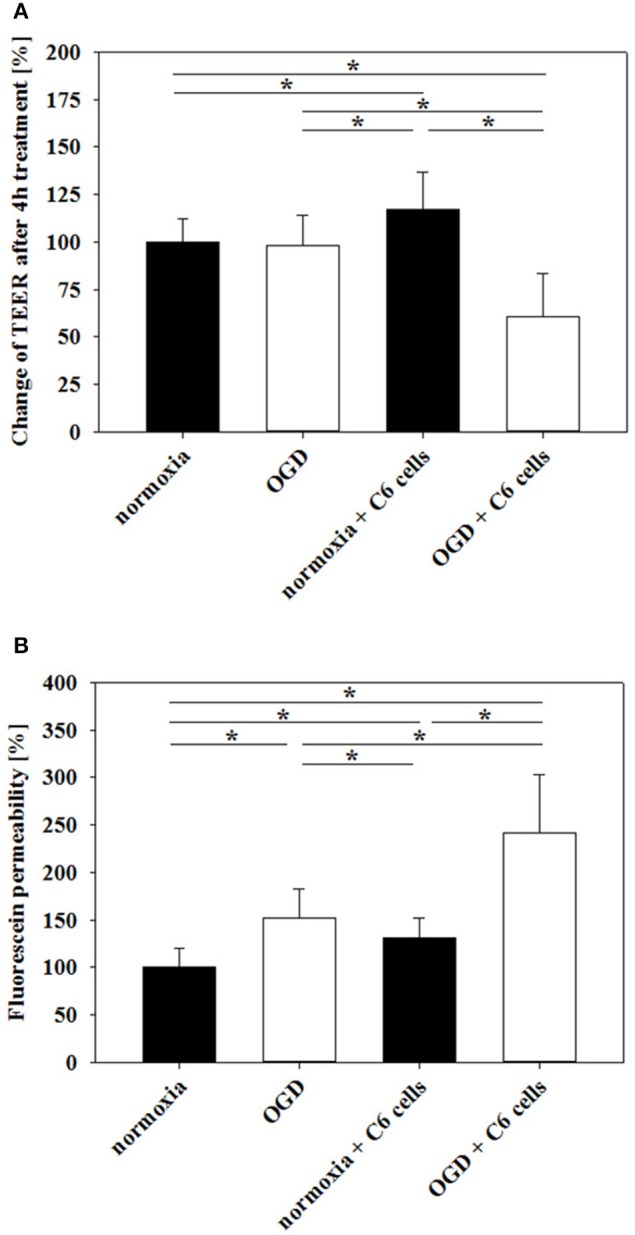
Influence of 4 h oxygen/glucose deprivation (OGD) treatment on barrier functionality of mono-cultured cerebEND layers or co-cultured with astrocytes (C6) on Transwell inserts measured by TEER (A) or fluorescein permeability (B). Statistical significance was labeled with *(p < 0.05, two-sided student's t-test with same variances). Data are presented as means ± SD (n = 11–59).